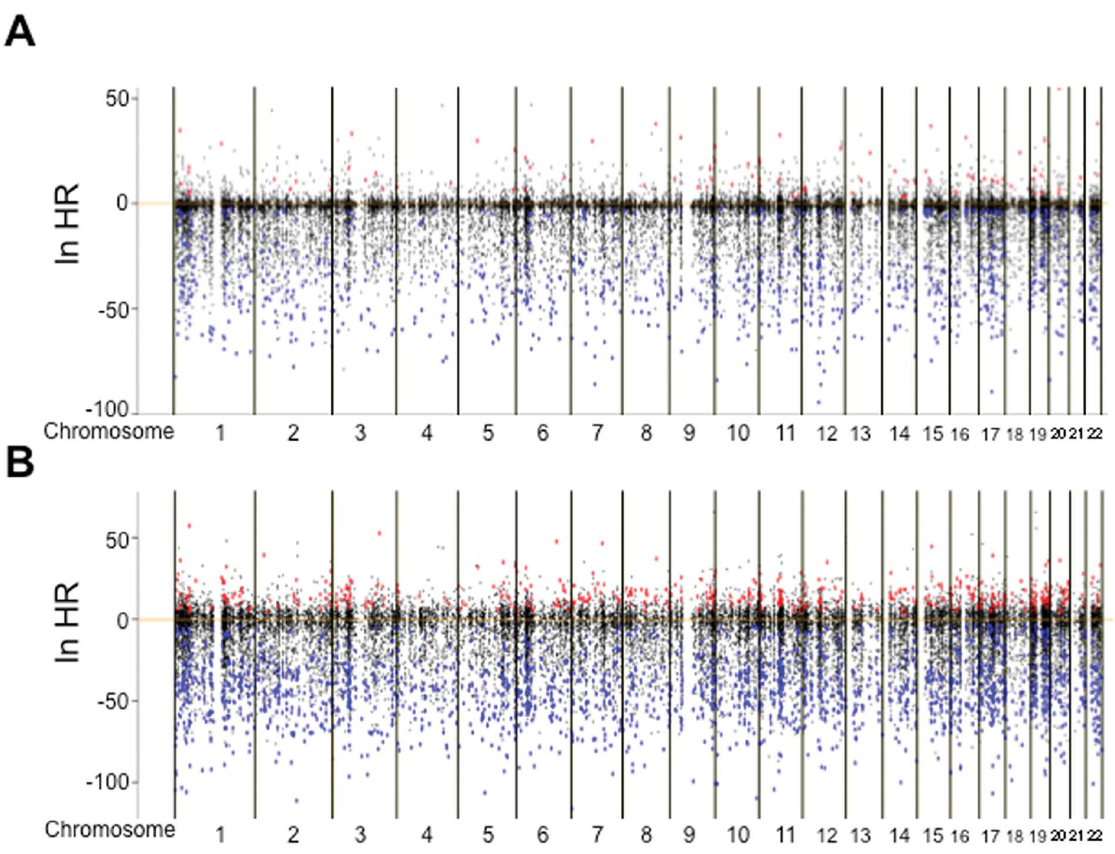
Figure 1. Hazard ratio (HR) obtained from the Cox regression model. Correlation between DNA methylation status (average b -values) and recurrence was examined in 145 samples of tumorous tissue ( A ) and 145 samples of the corresponding non-cancerous lung tissue ( B ) obtained from patients with lung adenocarcinomas who had undergone complete resection and had not received any adjuvant therapy after surgery. All of the examined 26,455 probes of the Infinium array are shown along the chromosomes. Red color means that higher b -values of the probes were observed in recurrence-positive patients than in recurrence-negative patients ( P , 0.001). Blue color means that lower b -values of the probes were observed in recurrence-positive patients than in recurrence-negative patients ( P , 0.001).